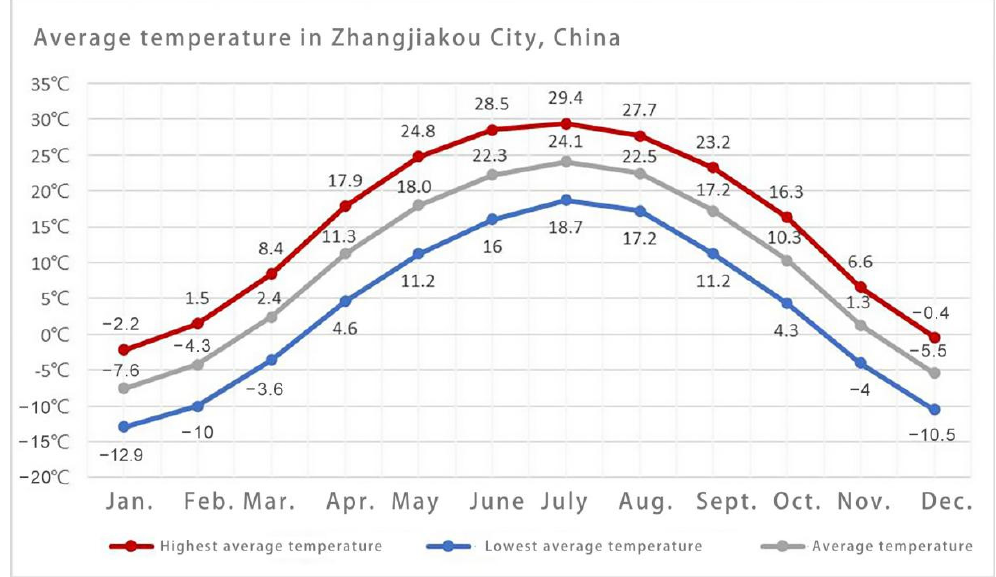
Figure 3. Monthly average temperature in Zhangjiakou City, China. (2) Humidity